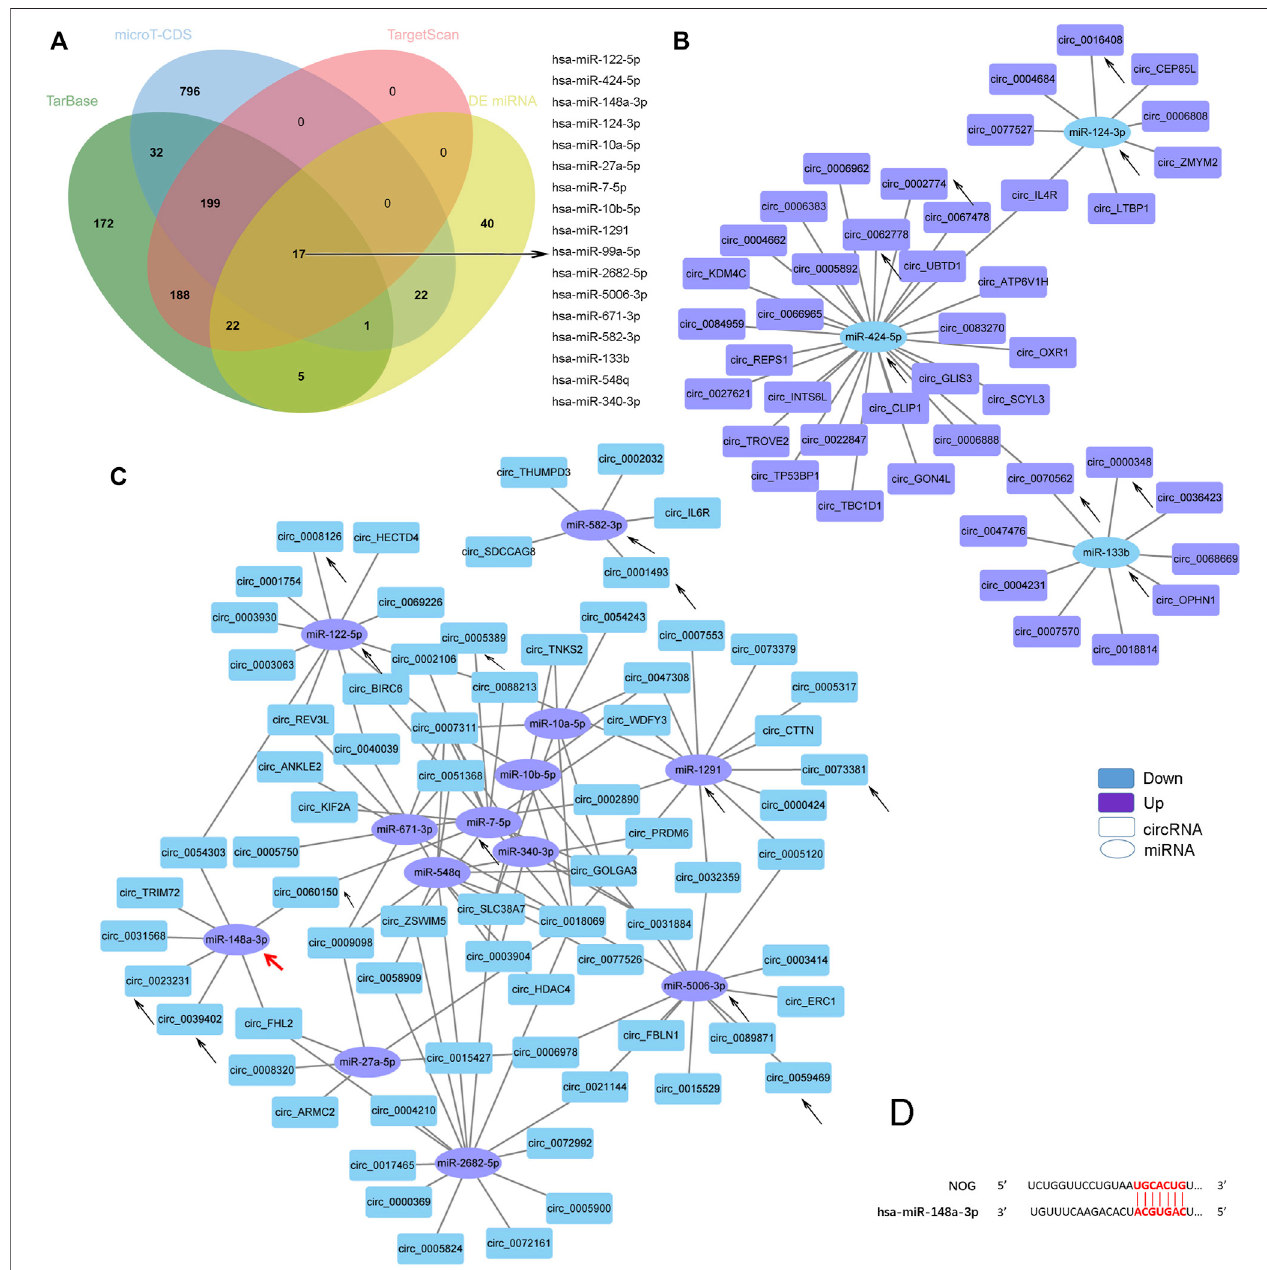
FIGURE5| PredictedTGF-betasignalingpathway-relatedcircRNA-miRNAnetwork. (A) .Venndiagramshowingthe17DEmiRNAsinAS-BMSCscompared with HD-BMSCs involved in the TGF-beta signaling pathway, as predicted by TarBase, micro-CDS and TargetScan. (B) . Network of circRNAs and miRNAs with up-down relationships potentially associated with the TGF-beta signaling pathway. (C) . Network of circRNAs and miRNAs with down-up relationships potentially associated with the TGF-beta signaling pathway. The circles indicate miRNAs, and the rectangles indicate circRNAs. Purple nodes indicate upregulated genes, and blue nodes indicatedownregulatedgenes(AS/HD).Theedgesindicatetheinteractionbetweentwonodes.TheblackarrowsindicatethekeyRNAs.TheredarrowindictesthemiR- 148a-3p that regulates NOG. (D) . Binding sites between miR-148a-3p and NOG were predicted by miRDB and TargetScan.